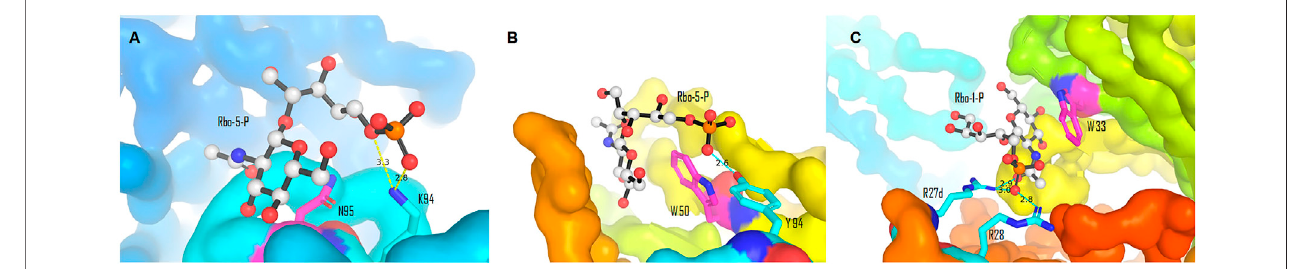
FIGURE8| Bindinginteractionsbetweenthe β -WTAmimicandanti – S.aureus antibodies. (A) Stackingandionicinteractionsbetweenantibody4462andRbo-5-P (Pdb 6DWI). (B) Interactions between antibody 6078 and Rbo-5-P (Pdb 6DW2). (C) Arginine “ tweezers ” motif (Pdb 5D6C). Pictures (A) – (C) were generated from reported Pdb fi les (Lehar et al., 2015; Fong et al., 2018) using PyMOL (Delano,